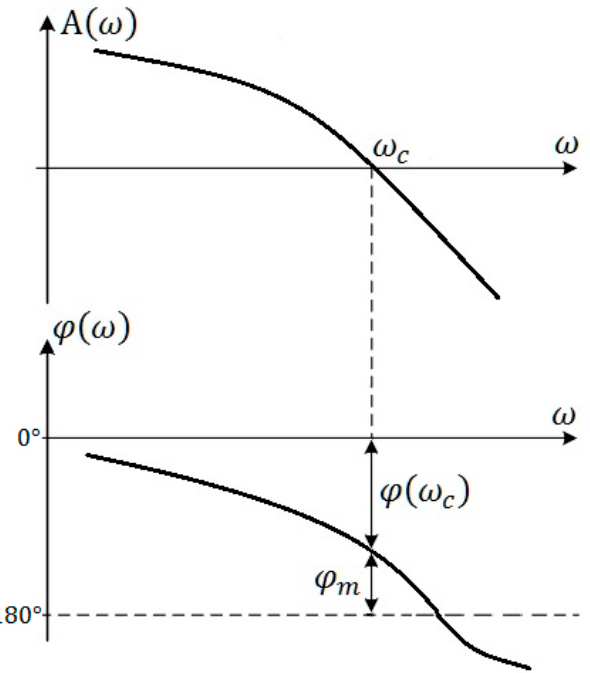
Figure 3. Stability criterion for LFC ACS.